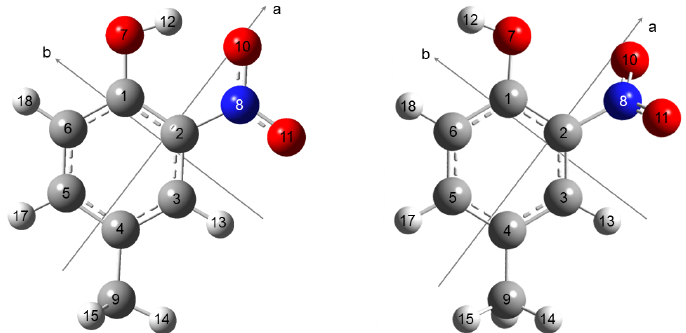
Figure 1. Molecular structures of the two conformers of 4 ‐ methyl ‐ 2 ‐ nitrophenol, 4MNP ‐ 1 ( left ) and 4MNP ‐ 2 ( right ). The carbon atoms are gray, hydrogen atoms white, oxygen atoms red, and the nitrogen atom is blue. The principal inertial axes a , b are indicated. The c ‐ axis is perpendicular to the ab plane.